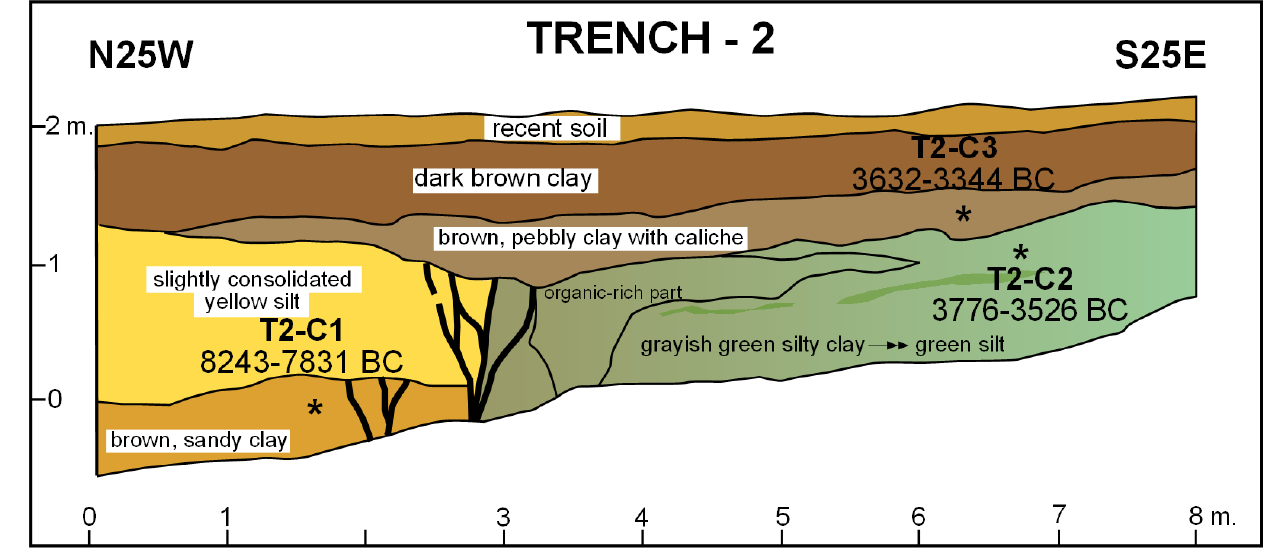
Figure 8. Log of Trench-2, eastern wall.